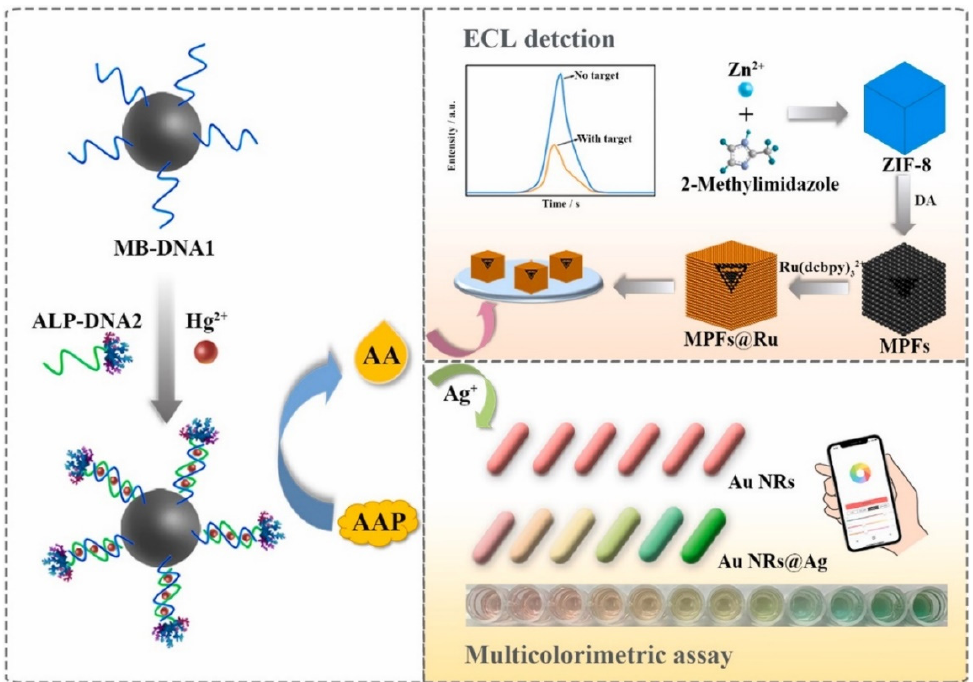
Figure 4. Scheme of the ECL and colorimetric sensor for Hg 2+ detection. Reproduced with permis ‐ sion from Ref. [57]. Copyright 2021, Elsevier.